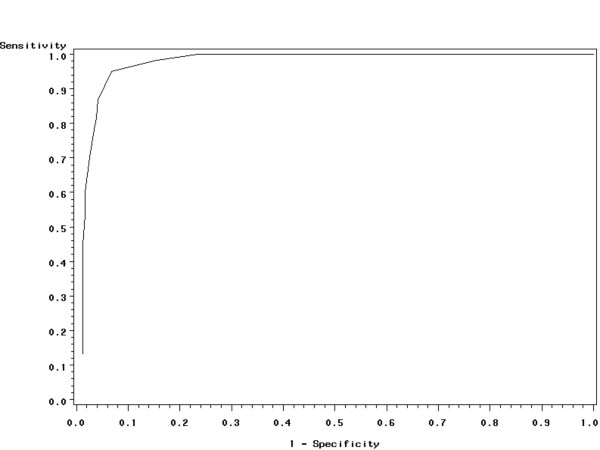
ROC curves indicated that the FLAM score value providing the largest sum of sensitivity plus specificity was 9 (area under the curve, AUC, 0.97).